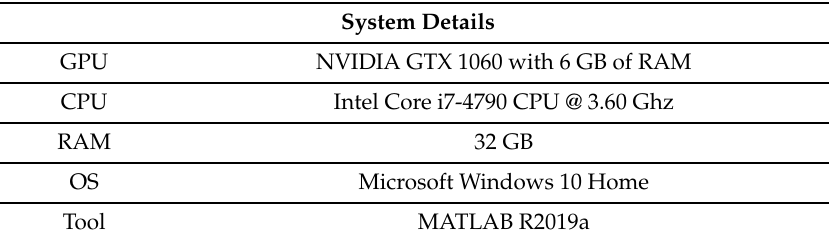
Table 2. System Details.